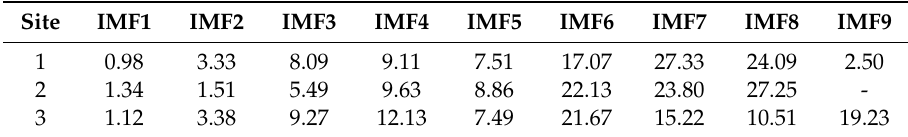
Table 3. The variance contribution rate of all IMF components